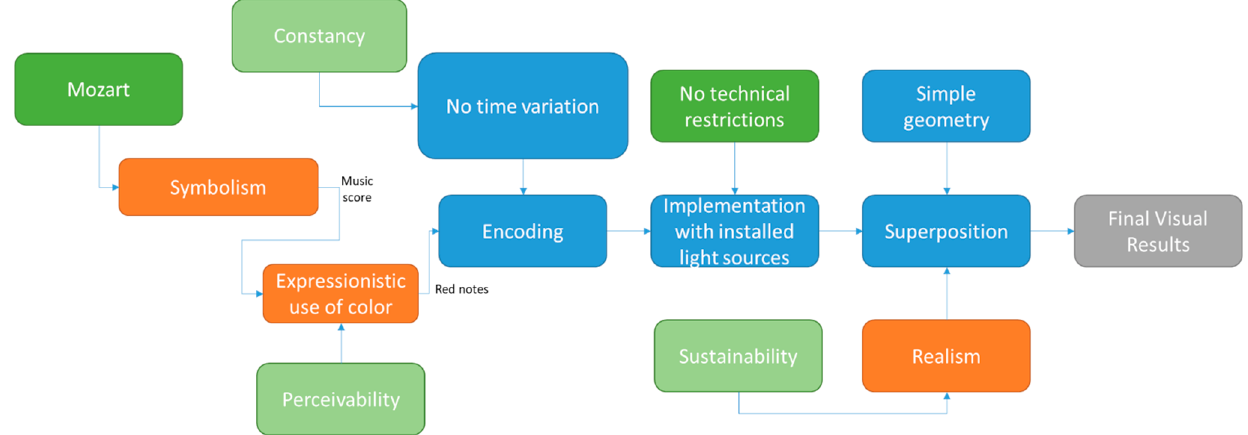
Figure 23. The working diagram for seasonal lighting of historical building façade (Tribute to Mozart).